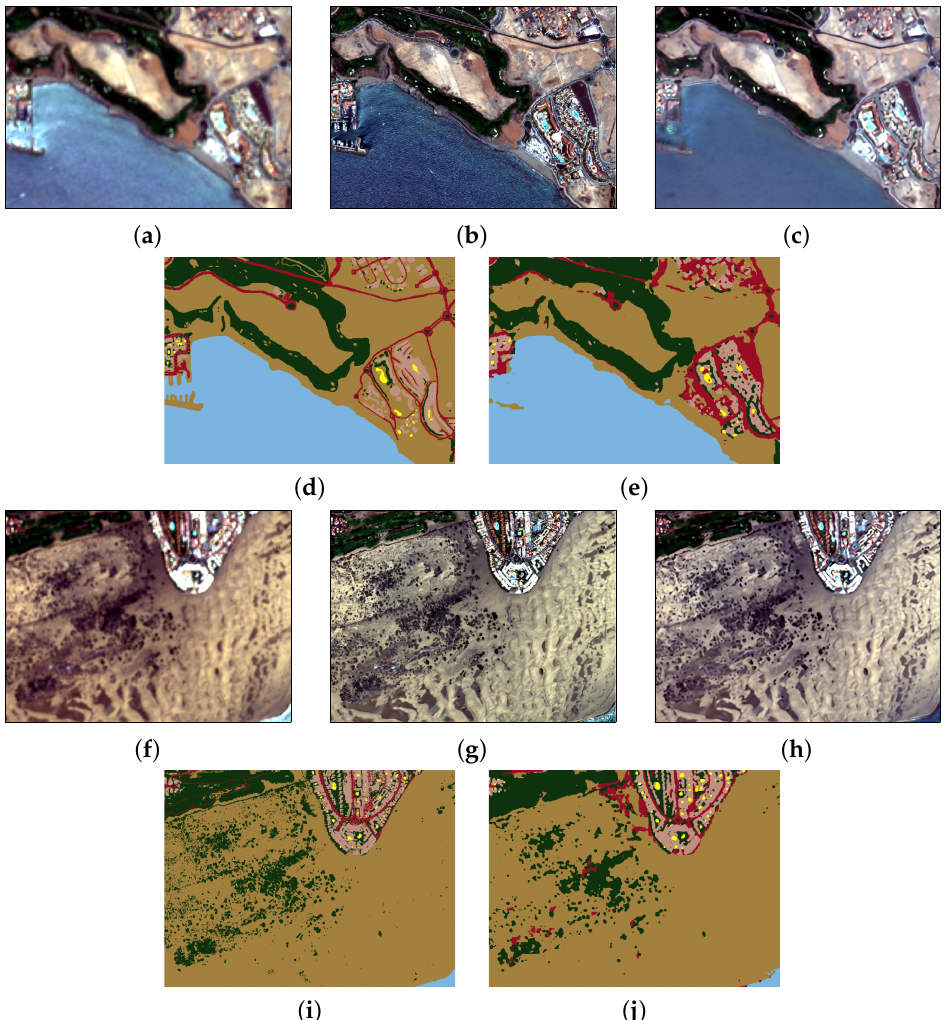
Figure 11. Results obtained on the test set of the Maspalomas dataset: ( a,f ) Sentinel-2 bicubic input image; ( b,g ) WorldView GT; ( c,h ) SISR results; ( d,i ) SSSR GT, ( e,j ) SSSR results. The colormap is the same as depicted in Figure